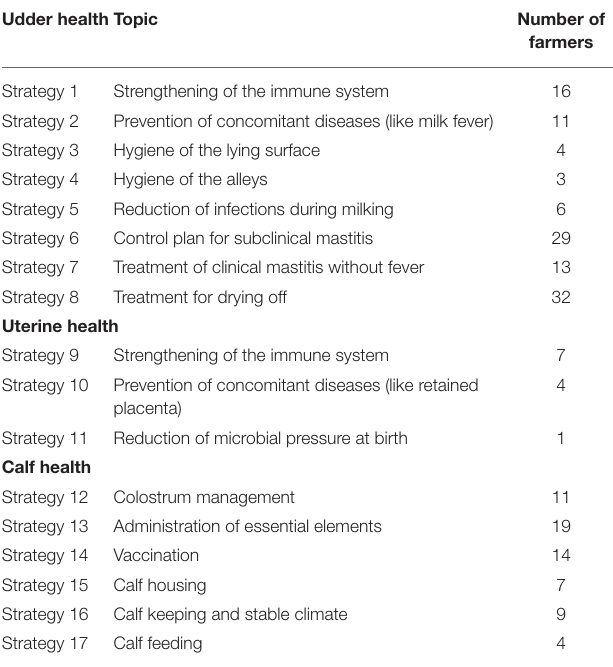
TABLE 1 | Description of farm characteristics of the intervention and control group.